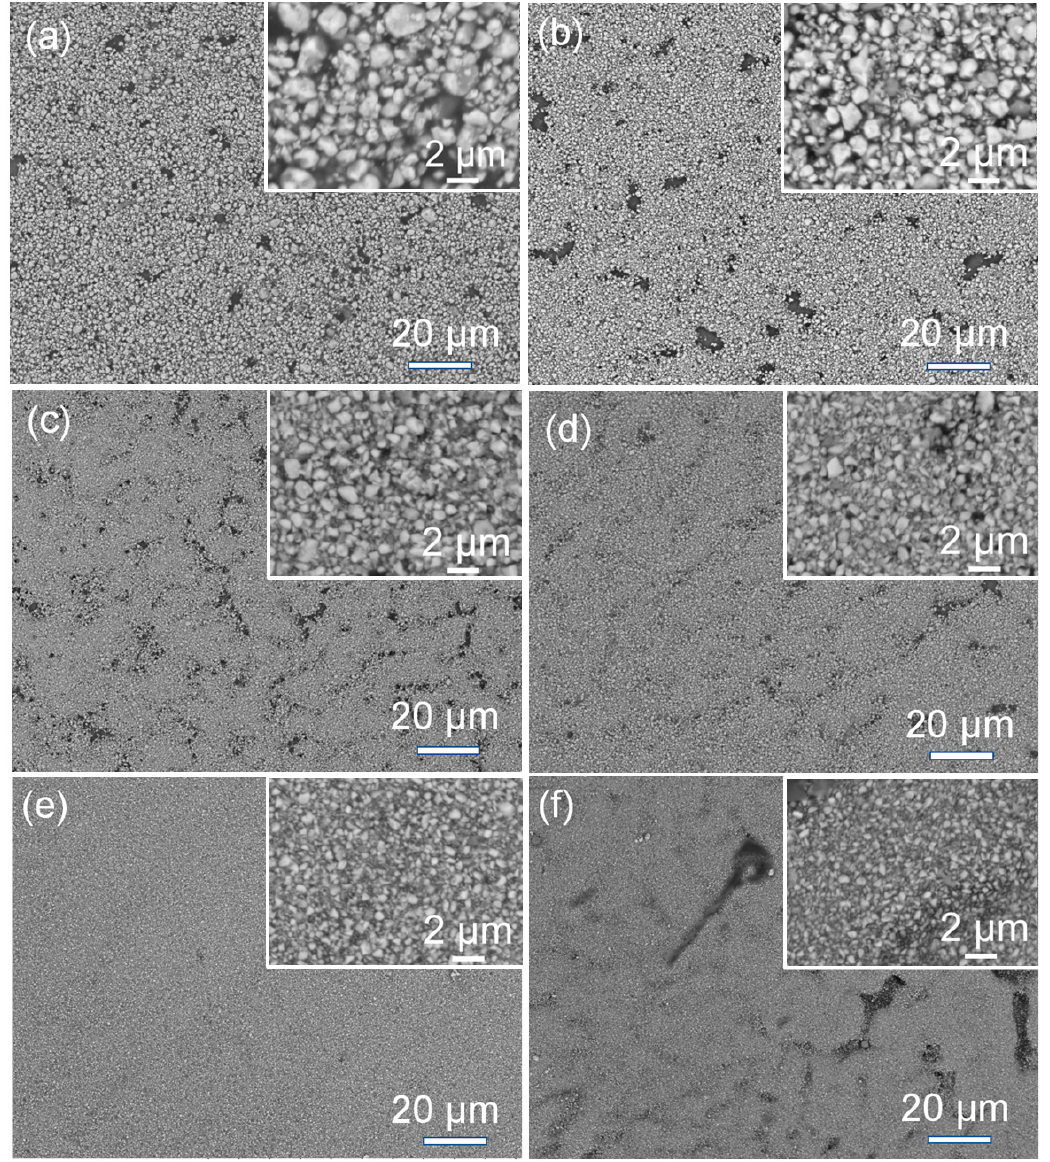
Figure 7. SEM images of the BPA films obtained via Route 2 using BT powders with various particle sizes as the functional inorganic filler ( M BT / M polymer = 4): ( a ) D 90 = 1.9 µ m, ( b ) D 90 = 1.6 µ m, ( c ) D 90 = 1.27 µ m, ( d ) D 90 = 0.99 µ m, ( e ) D 90 = 0.83 µ m and ( f ) D 90 = 0.61 µ m.